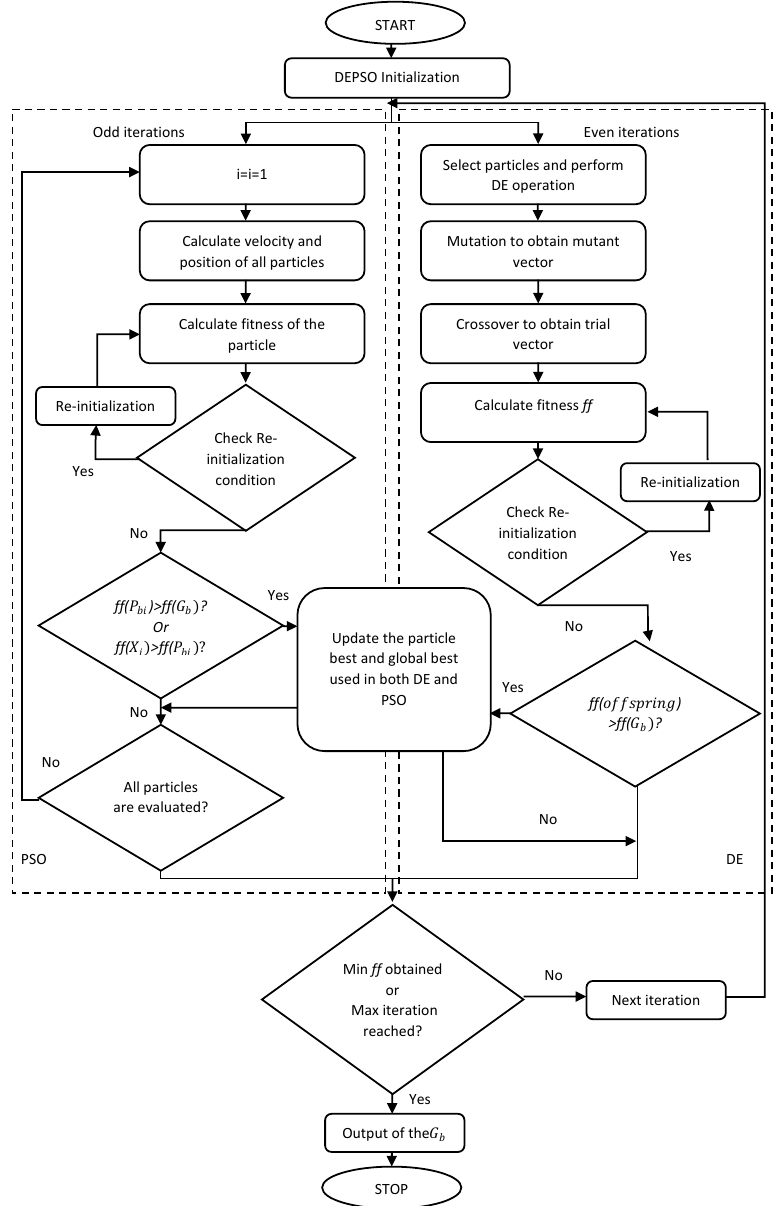
Figure 9. Flowchart of the forecasting strategy based on the DEPSO technique.